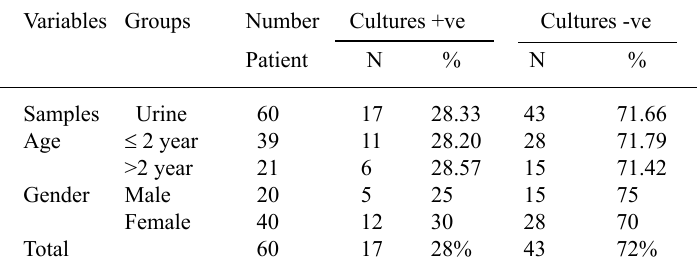
table 1. The percentage of risk factors associated with a patient infected. Variables